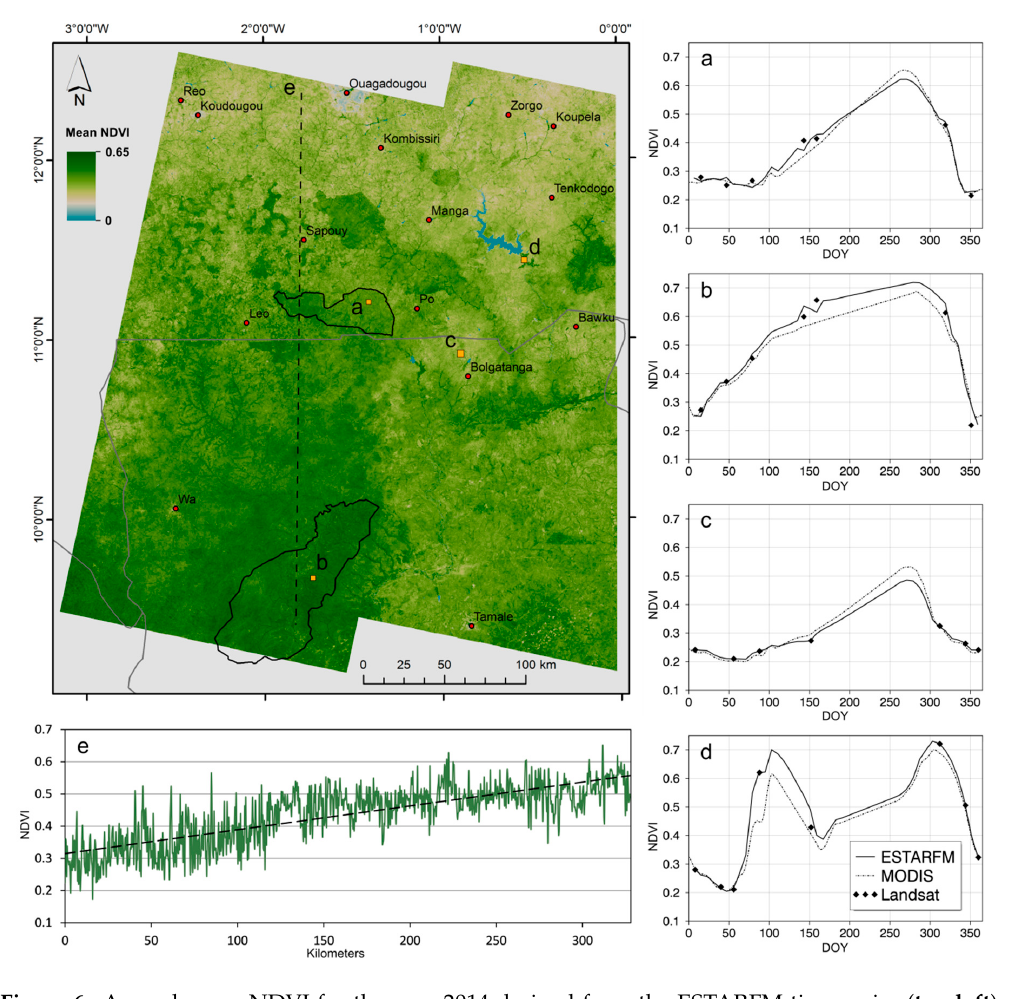
Figure 6. Annual mean NDVI for the year 2014 derived from the ESTARFM time series ( top left ). Temporal plots of ESTARFM, MODIS and Landsat time series of four different areas for the year 2014 (marked in orange in the map): semi-natural savanna area on Nazinga game ranch ( a ); semi-natural savanna area in the Mole National Park ( b ); rain-fed agricultural area ( c ); irrigated agricultural area ( d ); Spatial transect across the study area from north to south (( e ), see dashed line in the map); dashed line in the plot represents the linear trend line.